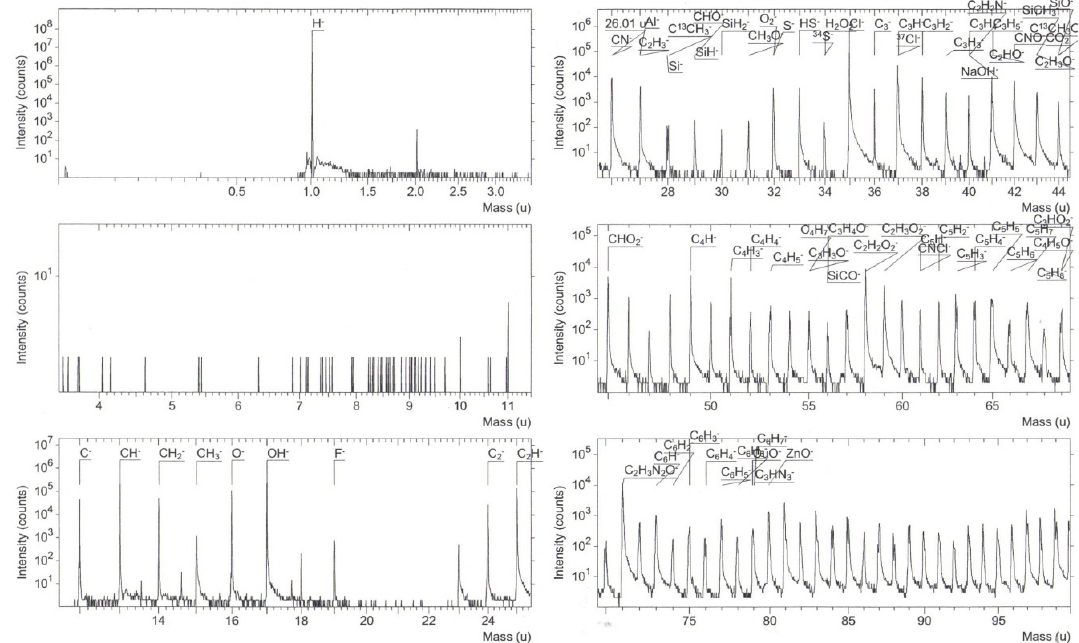
Figure 9. Mass spectrometry for the Cu-doped ZnO film obtained from six dips in copper chloride and tested for propane sensing.